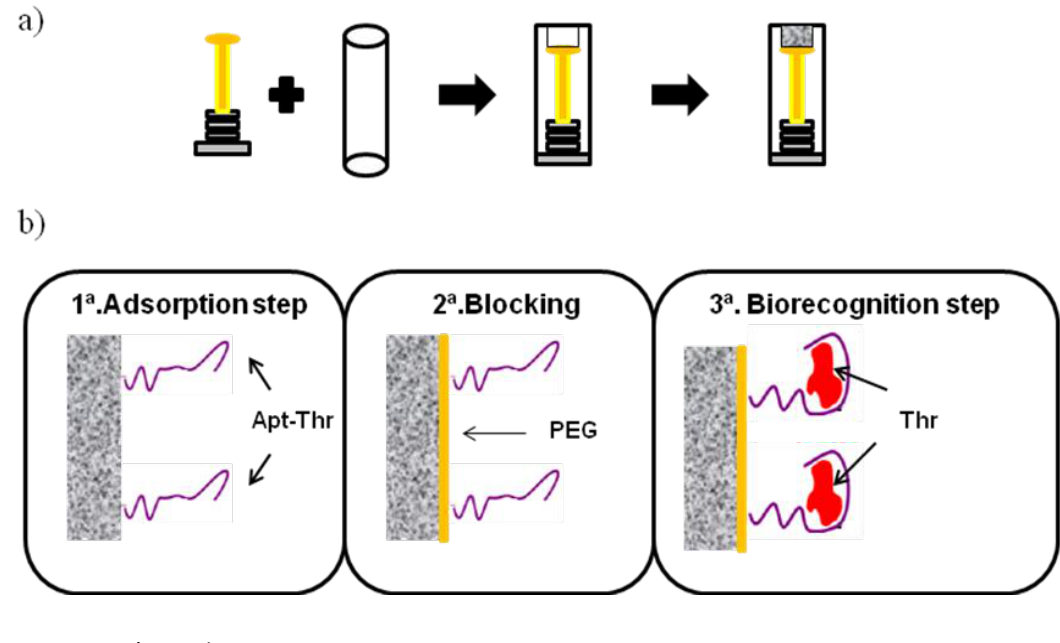
Figure 1. ( a ) Scheme of the manufacture of graphite-epoxy composite electrodes, ( b ) Steps of the biosensing